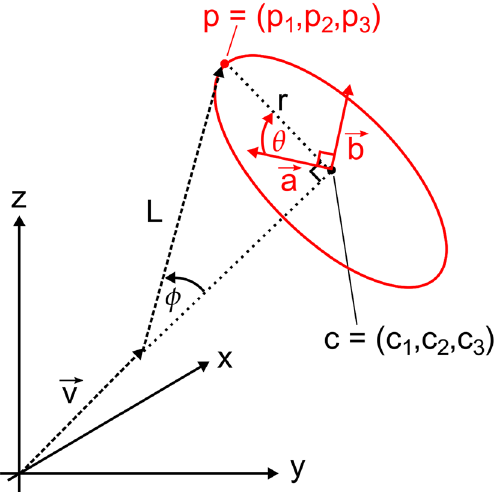
Figure 6. Vector diagram of the method used to generate structures. Briefly, we find the center c of a circle (shown in red) of possible locations from the previously generated parts of the structure along with the newly sampled length L and deviation angle φ for the current domain. We then obtain orthogonal unit vectors b in the plane of the circle and construct the parametric equation of the circle in 3D space in terms of c , b . Finally, we randomly generate another angle θ to pick a point on that circle which we take as the sampled location of the distal end of the current